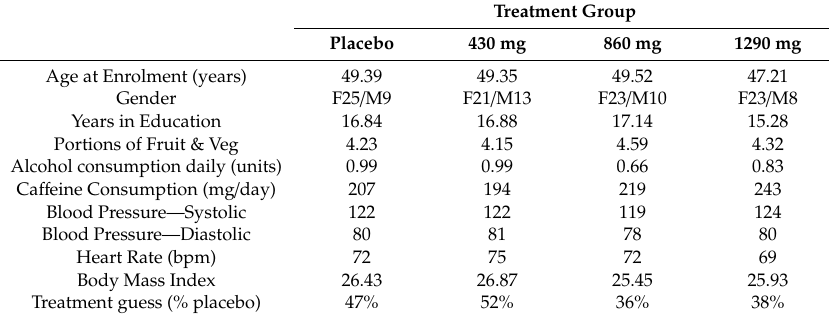
Table 1. Demographic details of the randomised participants (i.e., Day 1—acute analysis sample). There were no significant di ff erences between groups on any measure. Note: the doses of finished product correspond to doses of 300, 600 and 900 mg native extract